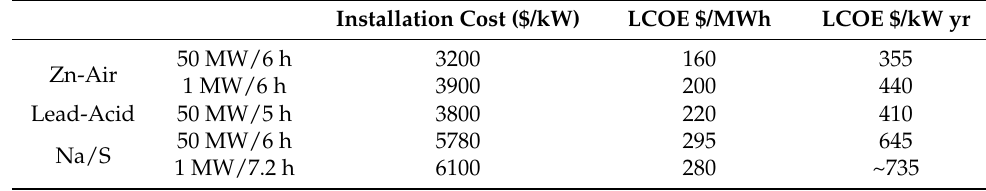
Table 1. Summary of installation cost and LCOE of zinc–air, lead–acid, and Na/S batteries [5]. Installation Cost